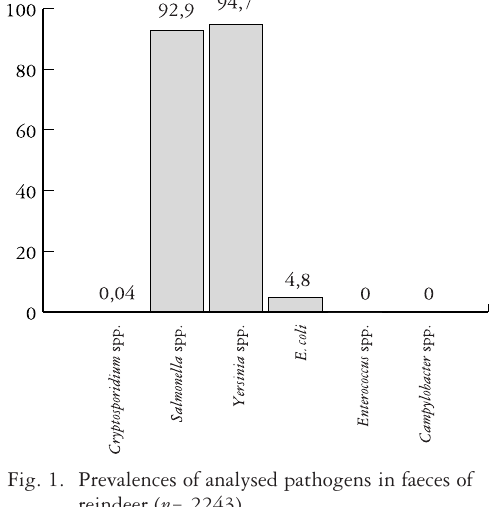
Fig. 1. Prevalences of analysed pathogens in faeces of reindeer ( n =